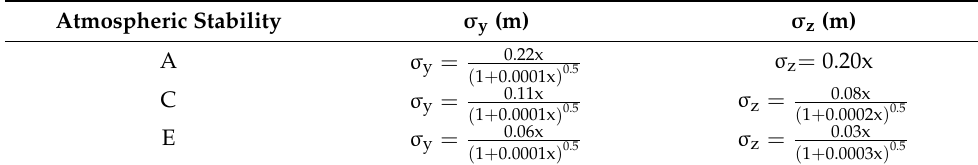
Table 4. Diffusion coefficient at different atmospheric